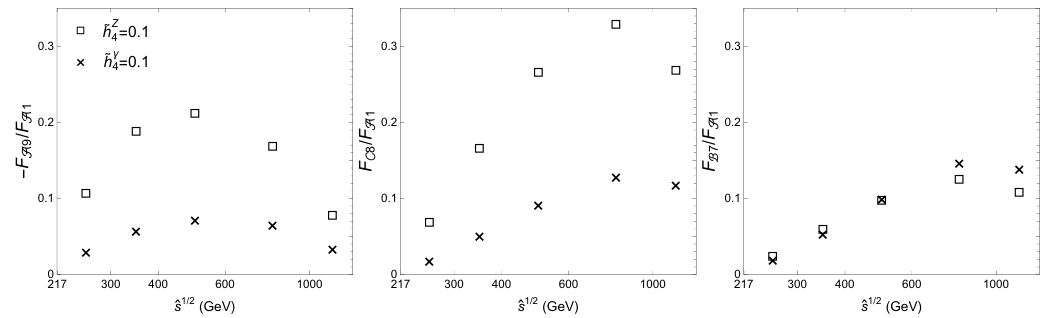
Figure 5 . The coe(cid:14)cients F (left panel), F (middle panel) and F (right panel) divided A 9 C 8 B 7 (cid:0) by F are shown. These coe(cid:14)cients are constrained to be identically zero by CP invariance. In A 1 each panel, 2 points give predictions for e h Z = 0 : 1, and points give those for e h (cid:13) = 0 : 1. For 4 4 (cid:2) each result, the values in the 5 bins, from left to right, are obtained after integration over ^ s in the regions ( m + m ) < ^ s 1 = 2 < 300, 300 < ^ s 1 = 2 < 400, 400 < ^ s 1 = 2 < 600, 600 < ^ s 1 = 2 < 1000 and Z H 1000 < ^ s 1 = 2 < 14000 in units of GeV.